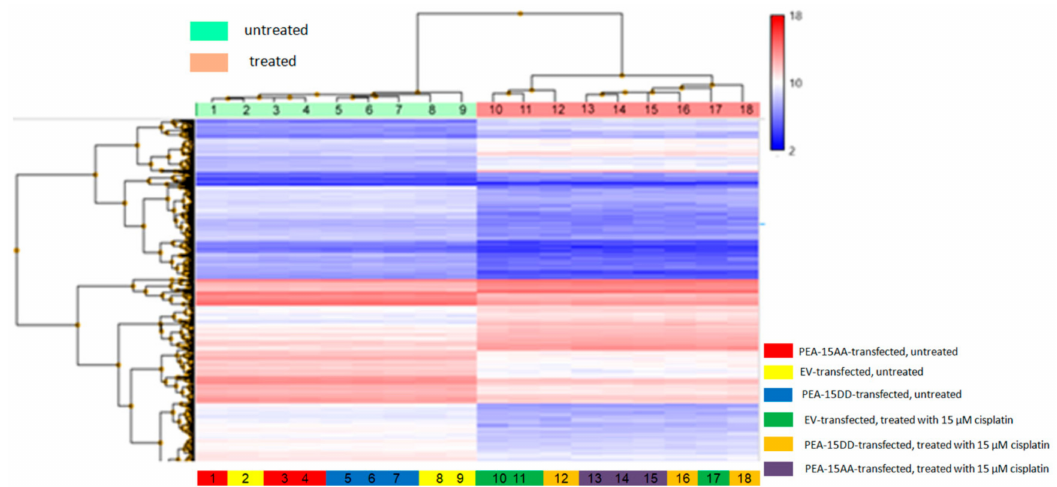
Figure 3. Heatmap of the transcriptome-wide Clariom TM S array, regulated genes with fold change cut-o ff at 2.0 for di ff erentially expressed genes and a p -value cut-o ff at 0.05 are